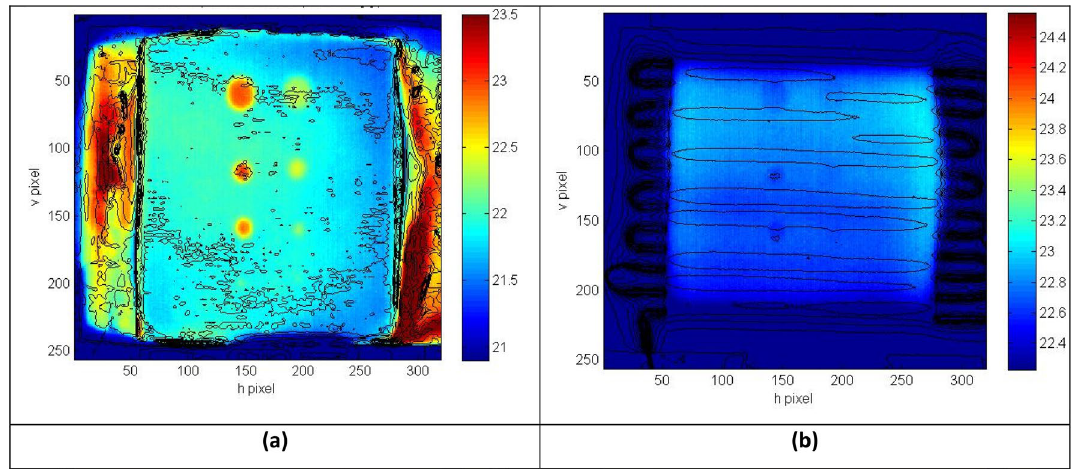
Fig. 5 Map of isotherms in the cooling phase ( a ) for the traditional thermography (heating for 3 s) and ( b ) SMArt thermography (heating for 240